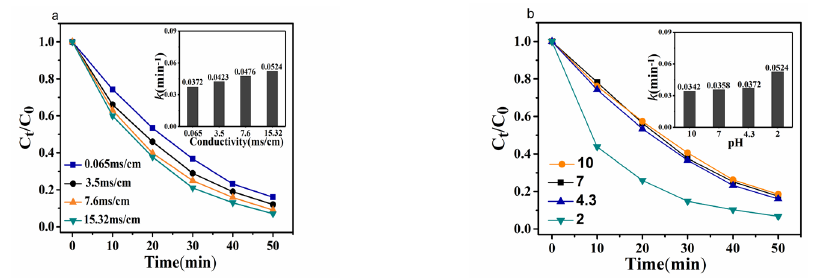
Figure 7. ( a ) Degradation efficiencies and rate constants of PFOA under different solution conduc- tivity; ( b ) Degradation efficiencies and rate constants of PFOA under different pH.